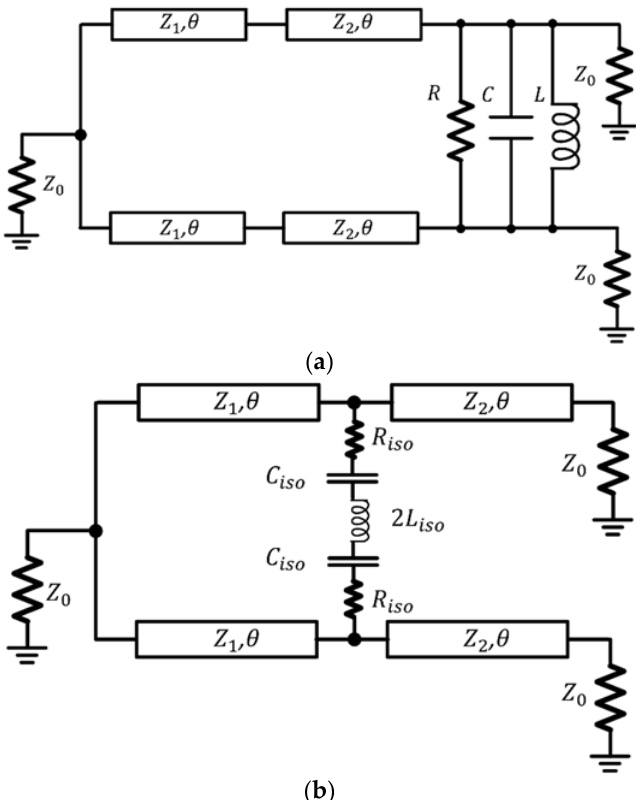
Figure 1. ( a ) The conventional dual ‐ band power divider and ( b ) our proposed dual ‐ band power divider.